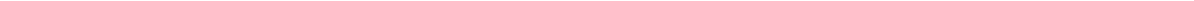
TABLE 2 | Comparison of optimum contribution of both sexes for maximization of genetic gain (MGa) with the desired rate of genomic inbreeding (Const) and truncation selection (Truncation 10%) strategies under random mating: results are the observed rate of genomic inbreeding ( (cid:49) F G ), the rates of genetic improvement ( (cid:49) TBV) in productivity and fitness and the rate of phenotypic change ( (cid:49) P ) in fitness after accounting for inbreeding depression, for selection indices emphasizing 0, 25, and 50% on fitness (I0, I25, I50).